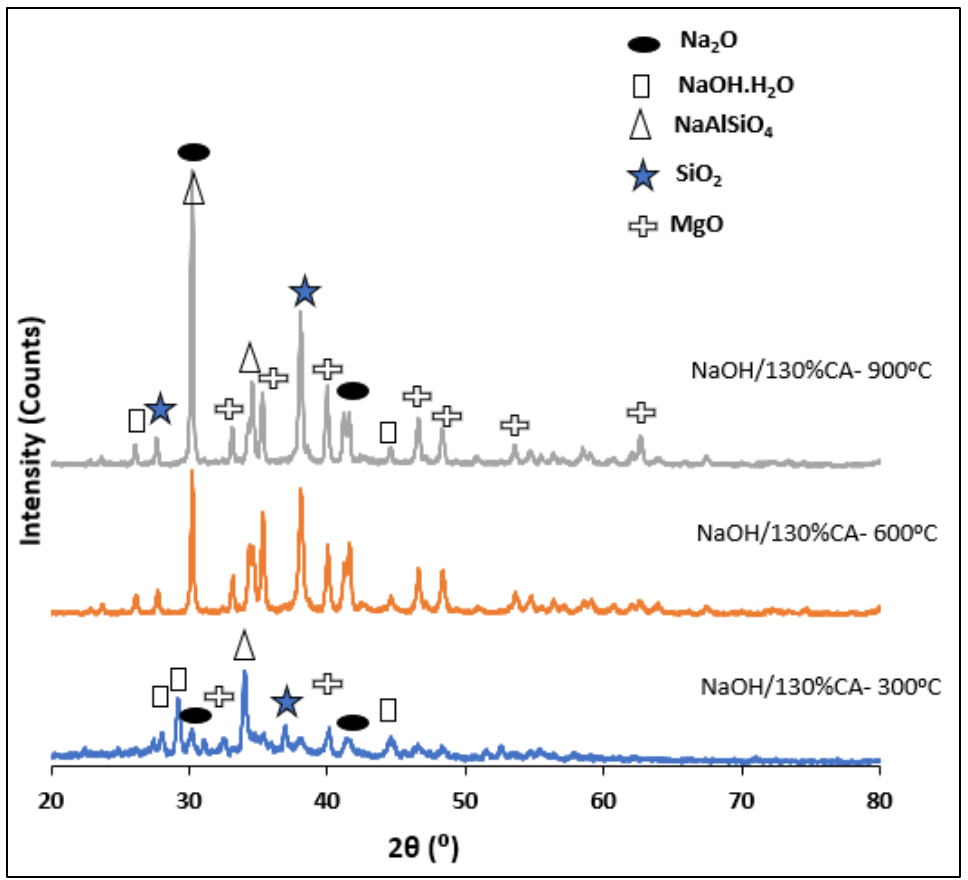
Figure 5. RXD pattern of NaOH/CA catalysts.